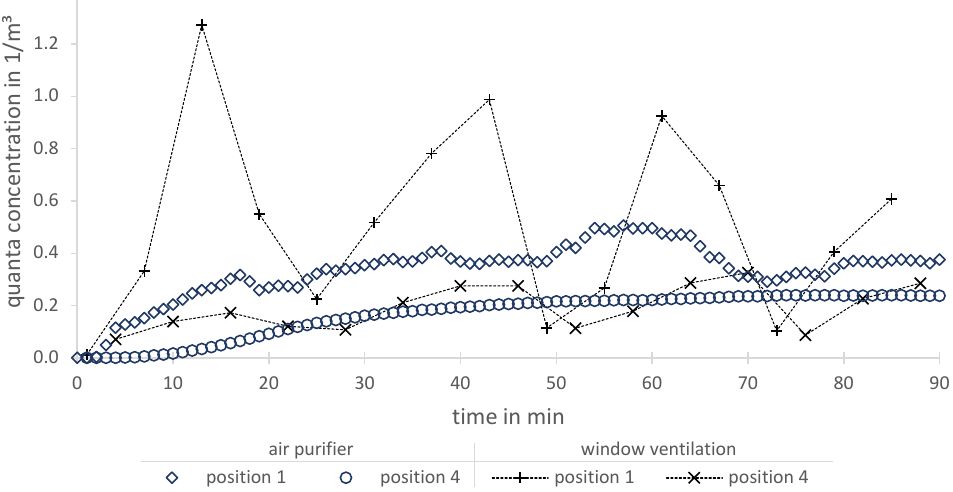
Figure 8. Comparison of quanta concentrations for a window ventilation and an air purification in a